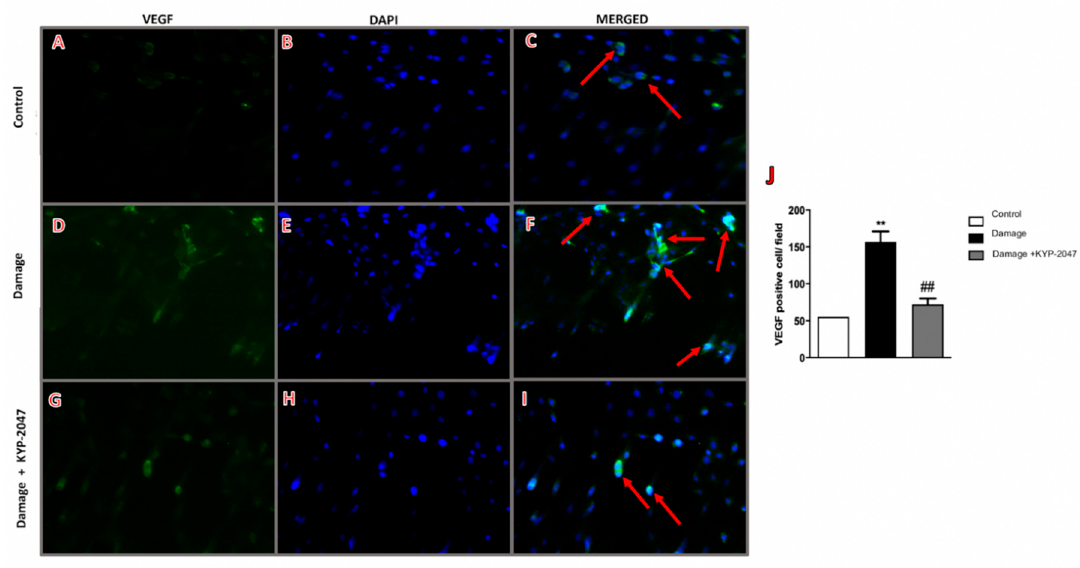
Figure 8. VEGF expression on saphene vein from tissue block culture study. Immunofluorescence analysis, on tissue block culture study, revealed an increase in VEGF expression in VSMCs from CVI-tissue block ( D – F ), see VEGF positive score ( J ) compared to control cells ( A – C ), see VEGF positive score ( J ). POP inhibition as treatment on CVI-damaged veins positively modulated angiogenesis as seen by VEGF expression in CVI + KYP-2047 tissue block group ( G – I ), see VEGF positive score ( J ). Red arrows refers to VEGF-positive cells merged with DAPI. Scale bar for figures F–I: 20 µ m, magnification 40 × Data represent the means of at least three independent experiments. One-way ANOVA followed by Bonferroni post-hoc. ** p < 0.01 versus Control; ## p < 0.01 versus CVI.